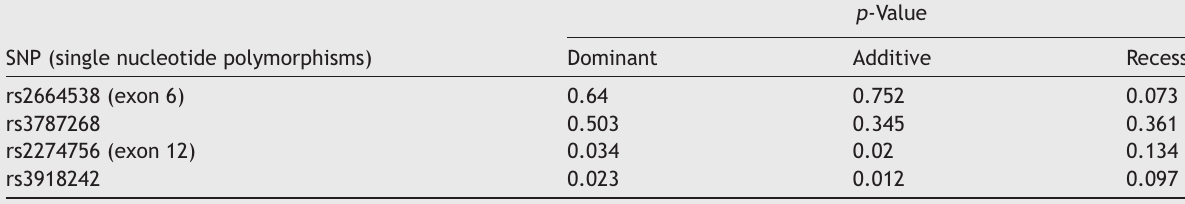
SNP (single nucleotide polymorphisms)